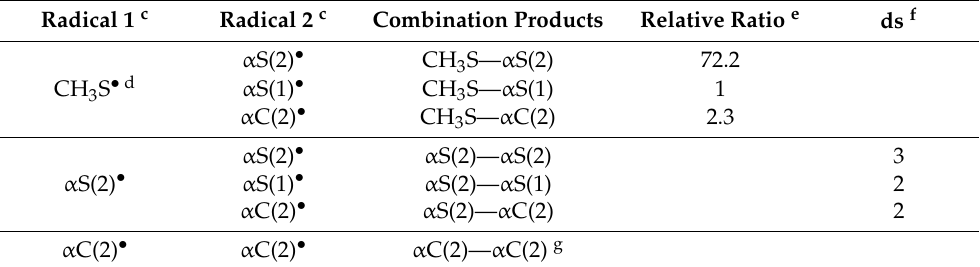
Table 4. Product formations by combination of various radicals in the experiment with starting material 2 a,b